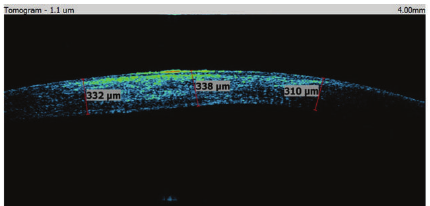
Figure 12: Pre- and postoperative Scheimpflug tomography (poste- rior elevation map), left eye.